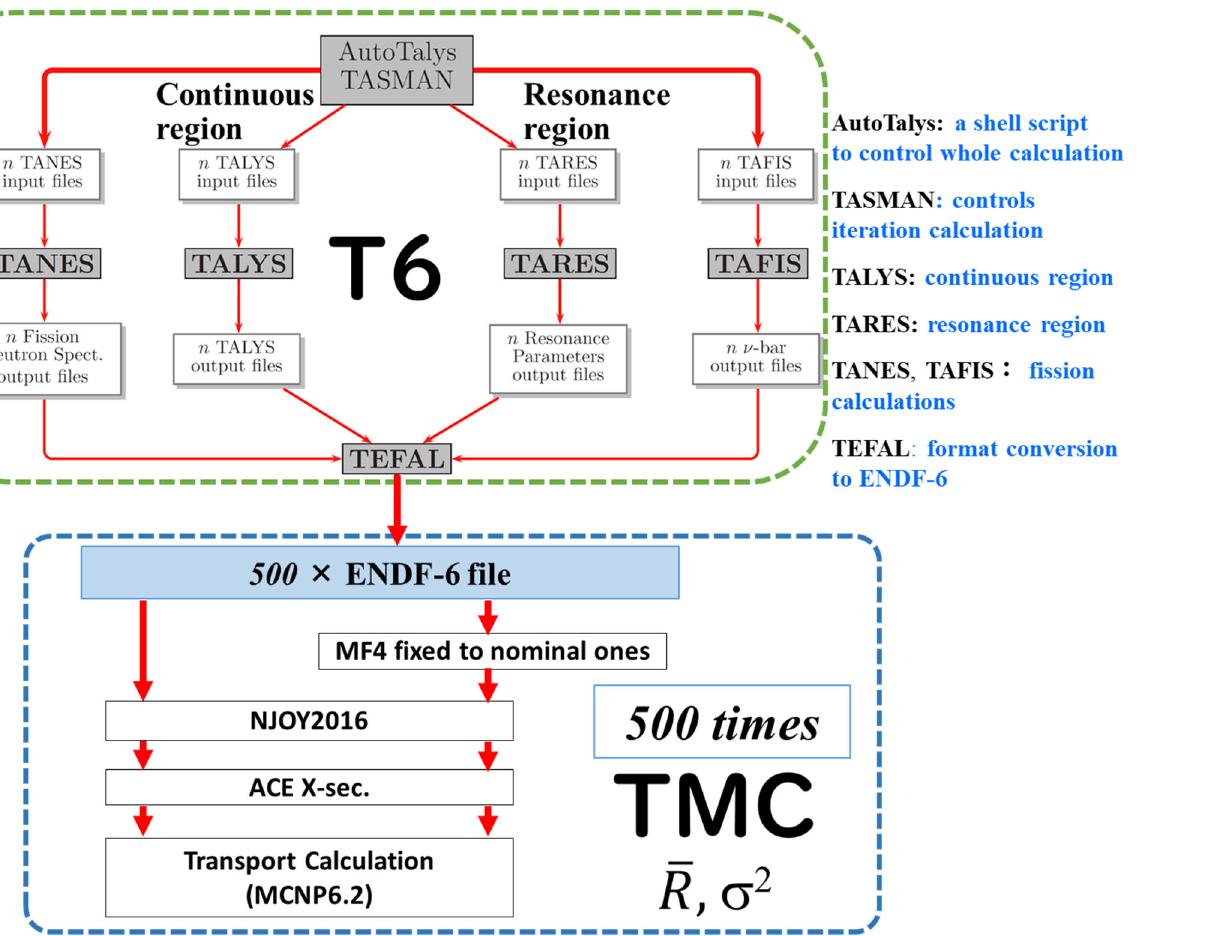
Fig. 1. Calculation scheme of cross section and associated covariance (T6, upper part), and the Total Monte Carlo (TMC) method (lower part). TANES and TAFIS in T6 were not used in the present